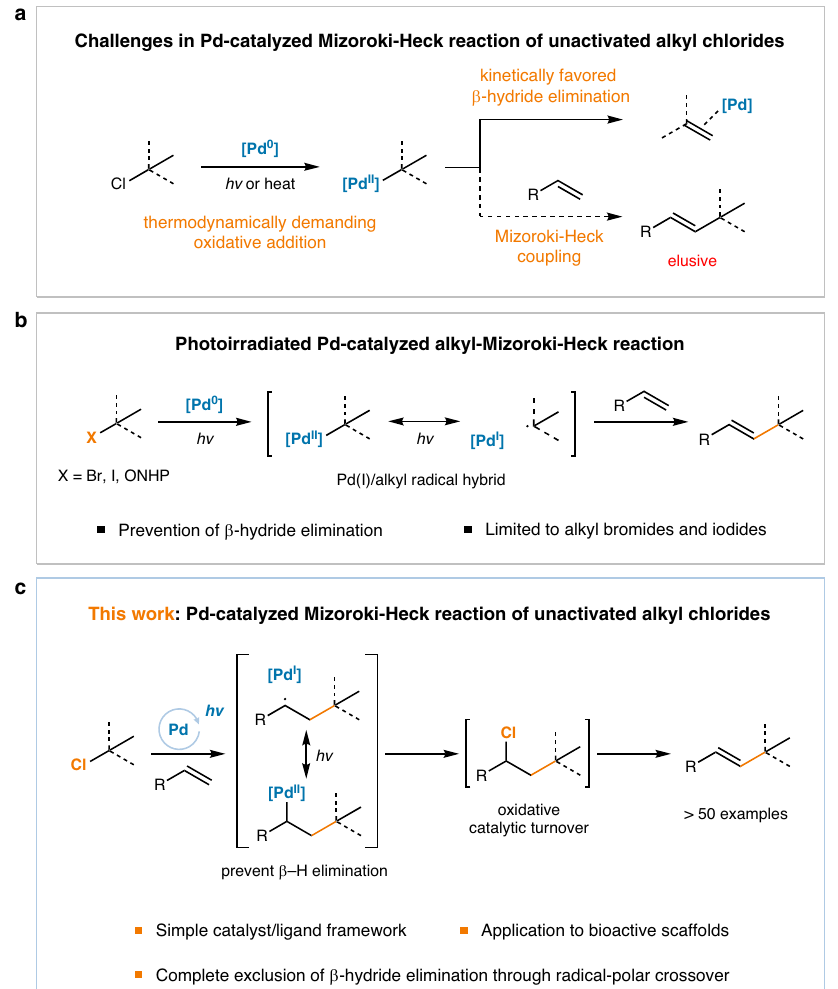
Fig. 1 Alkyl Mizoroki – Heck reactions. a Challenges in Pd-catalyzed Mizoroki – Heck reaction of unactivated alkyl chlorides. b Photoirradiated Pd-catalyzed alkyl Mizoroki – Heck reactions. c Pd-catalyzed Mizoroki – Heck reaction of unactivated alkyl